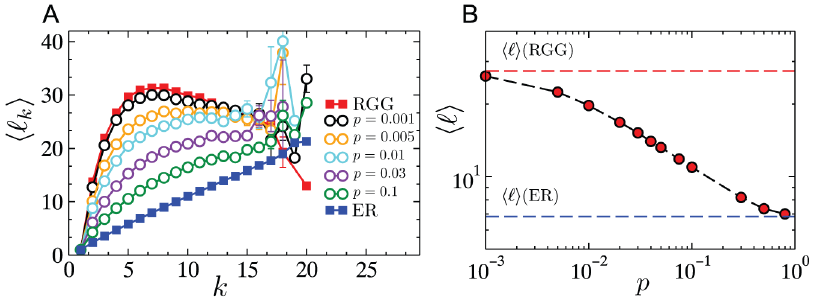
Figure 5. Effect of rewiring in RGGs. (A) Transition in network structure from an RGG towards an ER network through the process of rewiring. Multiple rewired versions (different values of p ) are shown together with the two extreme cases. (B) Average vertex load in RGG, ER and rewired versions of RGG as function of the fraction of rewired links p . Network parameters are: N ~ 500 , S k T ~ 6 : 0 . Data were averaged over 500 network realizations.